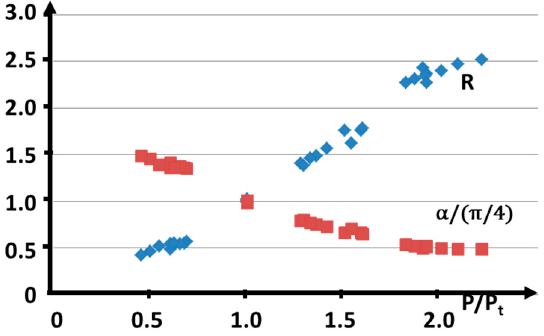
Figure 6. Variations of the normalized inclination angle of the KH front α /( π /4) and the aspect ratio R as a function of the normalized incident power P/P t.